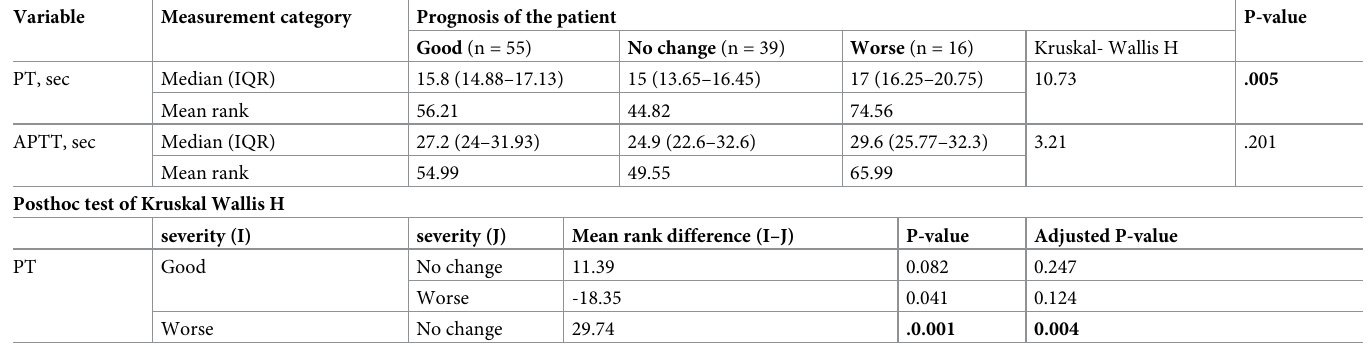
Table 5. Comparison of baseline basic coagulation tests between patient prognosis among COVID-19 patients attending at the Tibebe Ghion Specialized Hospital, COVID-19 treatment center 2021 (n = 110).